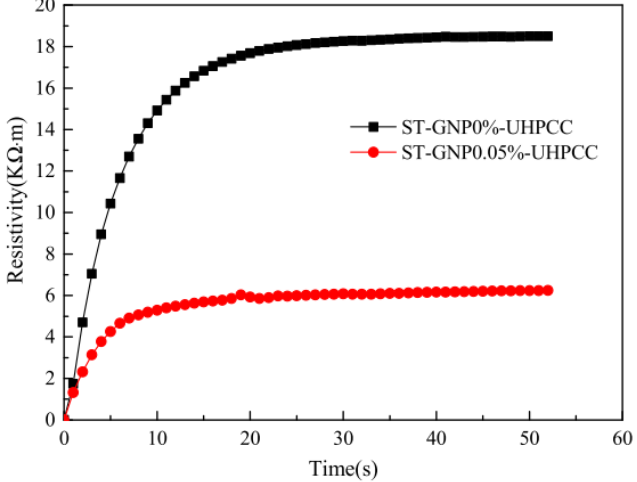
Figure 23. Variation of electrical resistivity with time. Reprinted with permission from Ref. [112]. Copyright 2019 Elsevier.